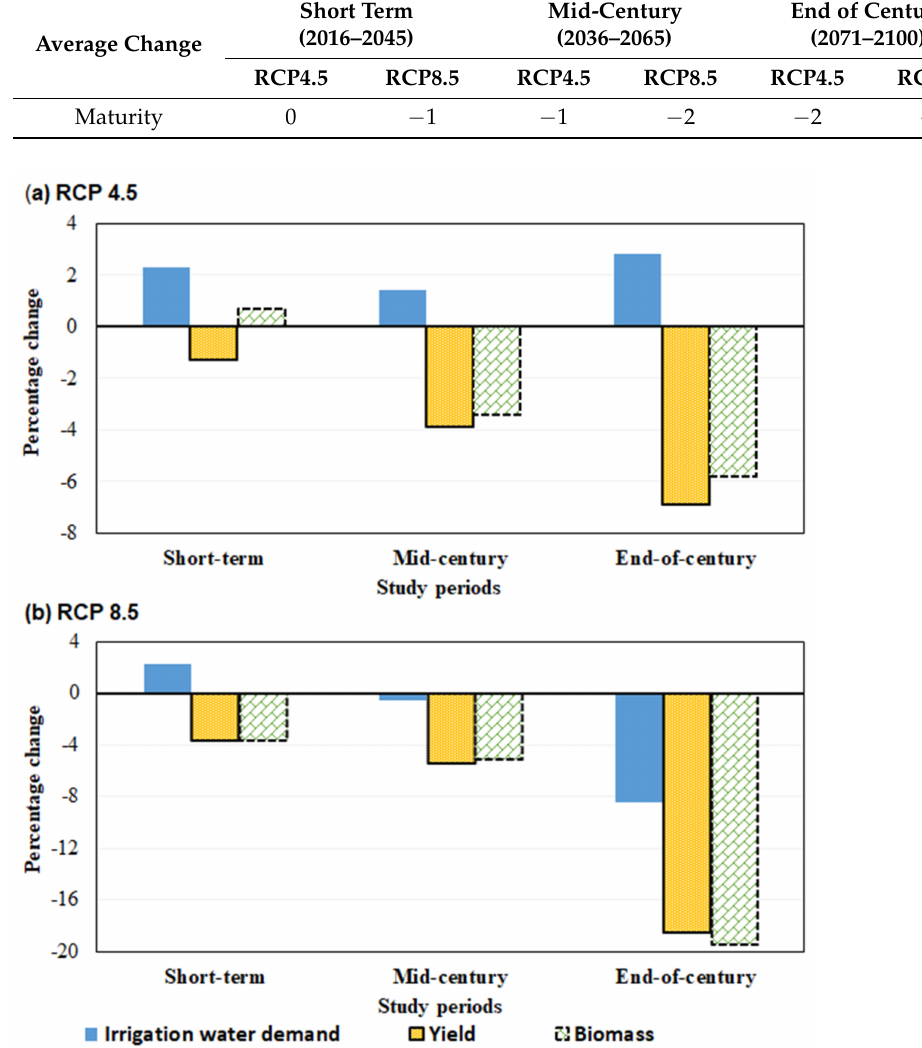
Figure 5. Impacts of climate change on future irrigation water demand, biomass, and yield of wheat grown in the Sunsari Morang Irrigation Scheme command area. Changes were calculated relative to the baseline period of 1981–2010.